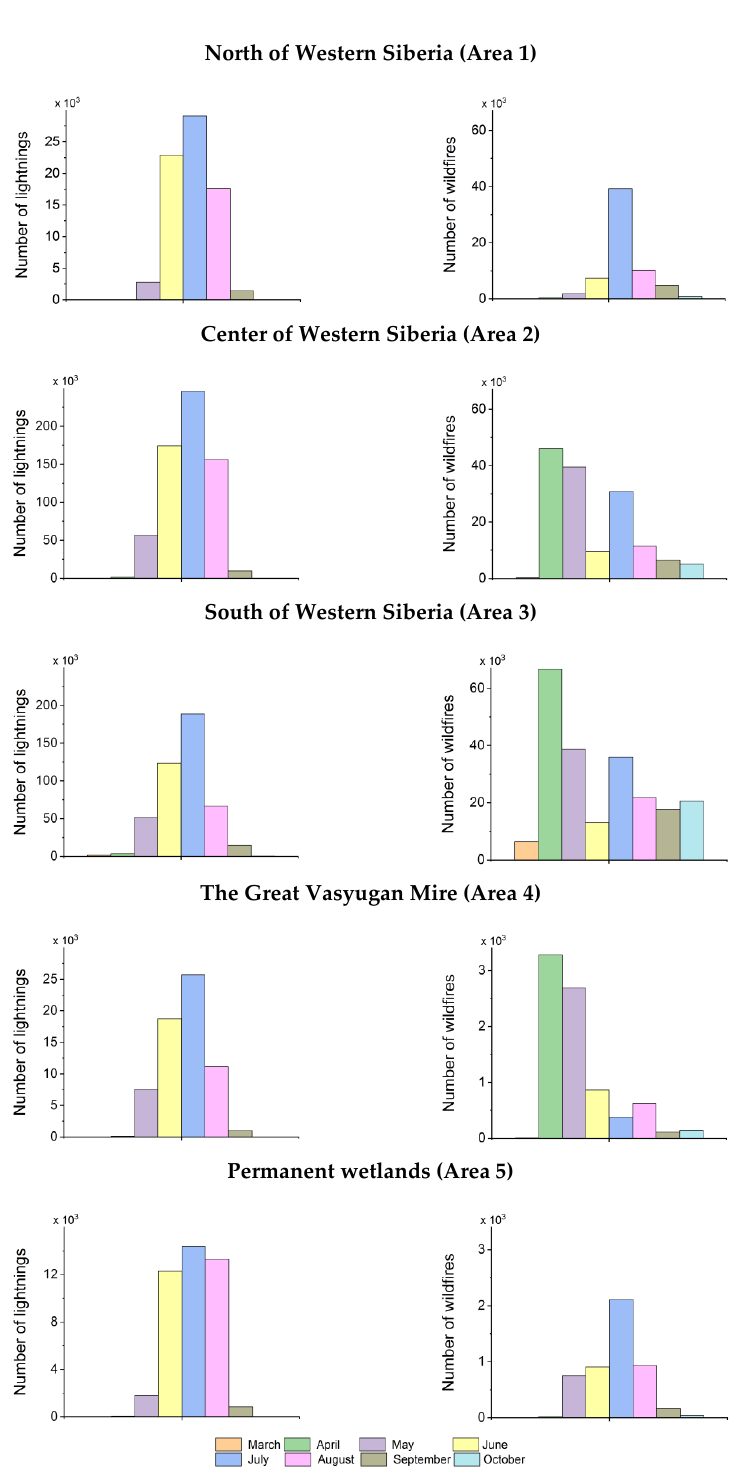
Figure 5. Seasonal variability in the total number of lightning (left column) and hotspots (right column) in Western Siberia from 2016 to 2021.